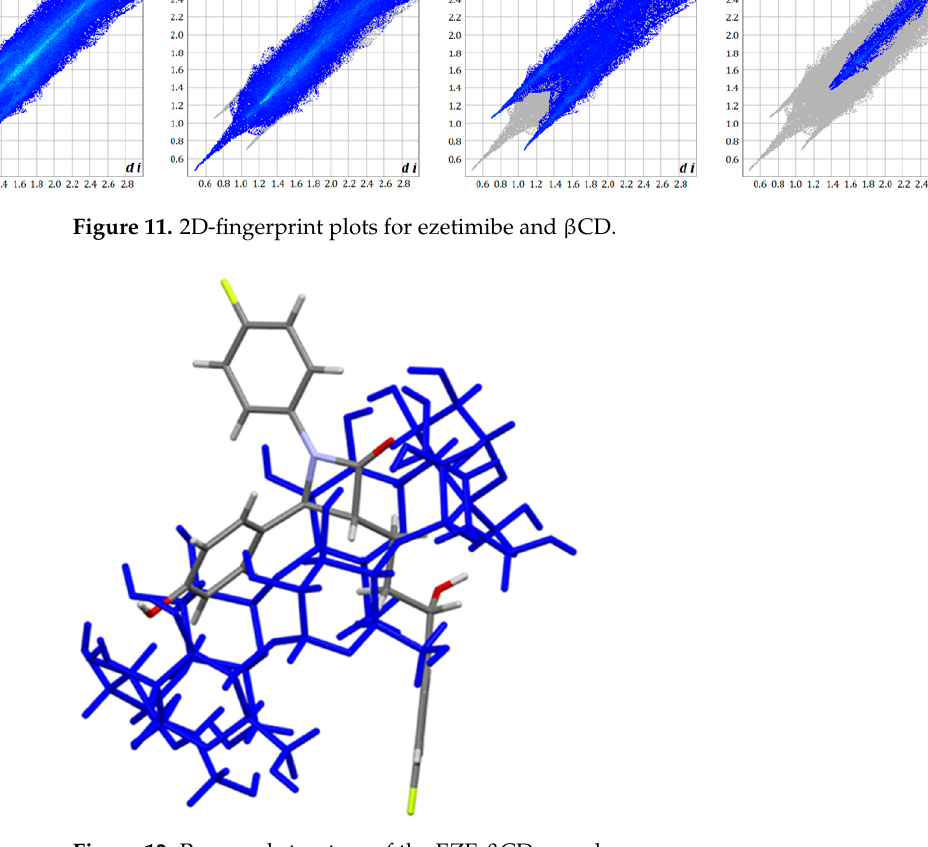
Figure 12. Proposed structure of the EZE- β CD Figure 12 . Proposed structure of the EZE- β CD complex.